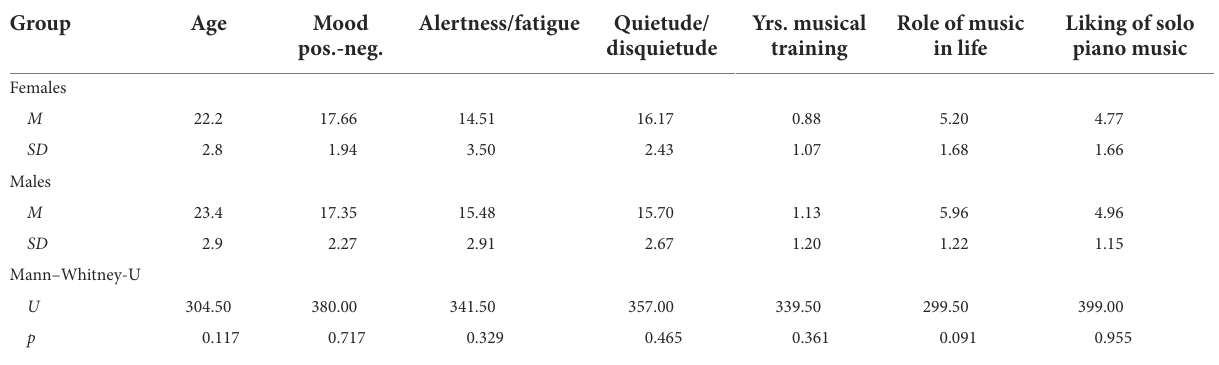
TABLE 1 Participant characteristics I.